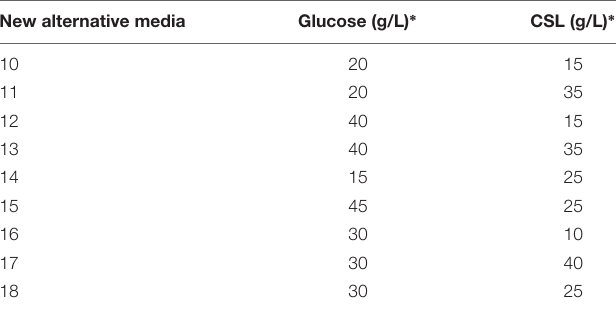
TABLE 2 | Variations in alternative medium composition formulated with glucose and